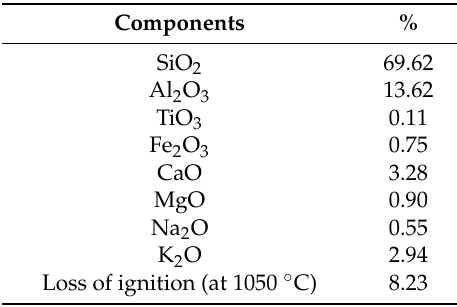
Table 2. Chemical composition of the zeolite used as analyzed by Imerys Minerals Bulgaria AD and reported in the technical data sheet provided online by ZeolifeTM Company.